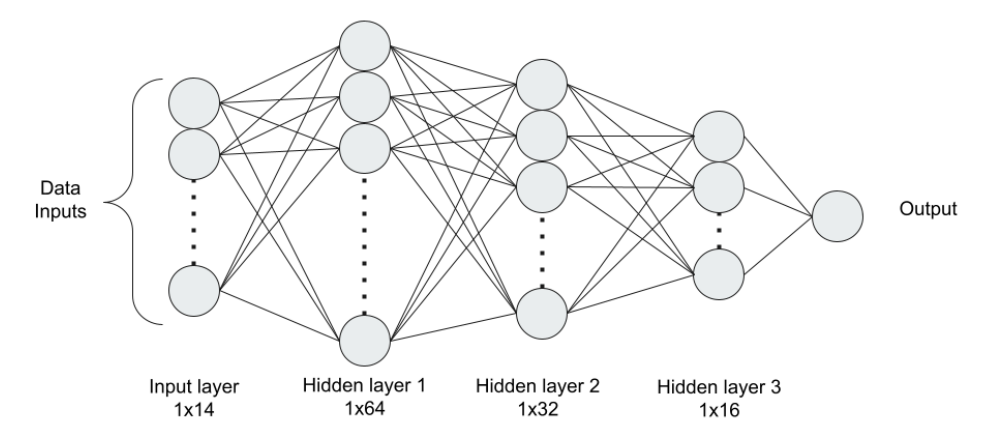
Figure 3. ANN model structure.